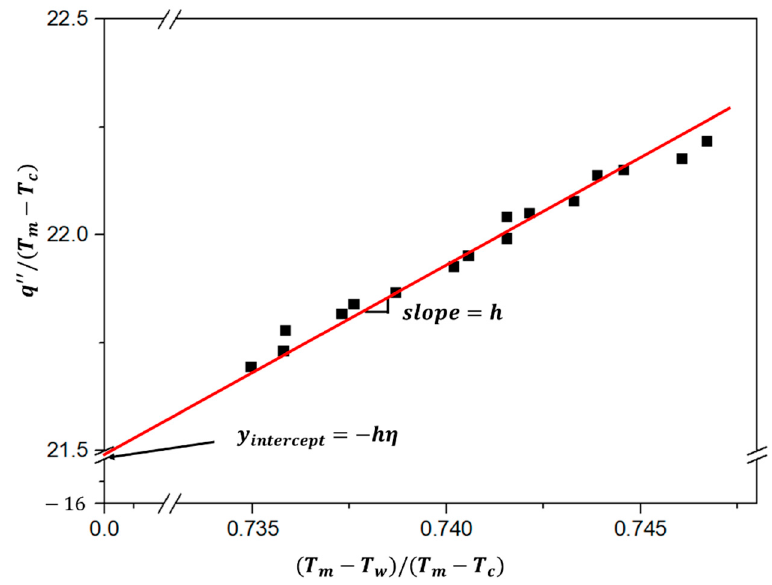
Figure 4. Linear fitting of heat flux and wall temperature.